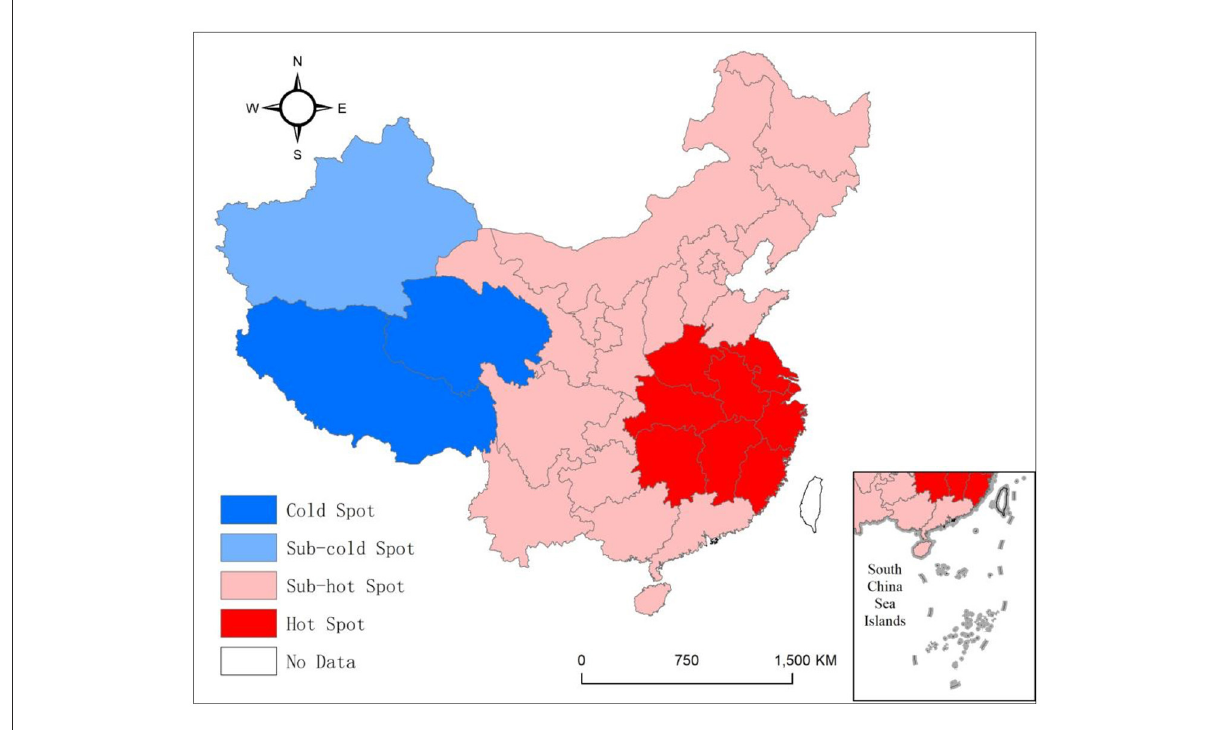
FIGURE2 Distribution of hot and cold spots of OAV in China.